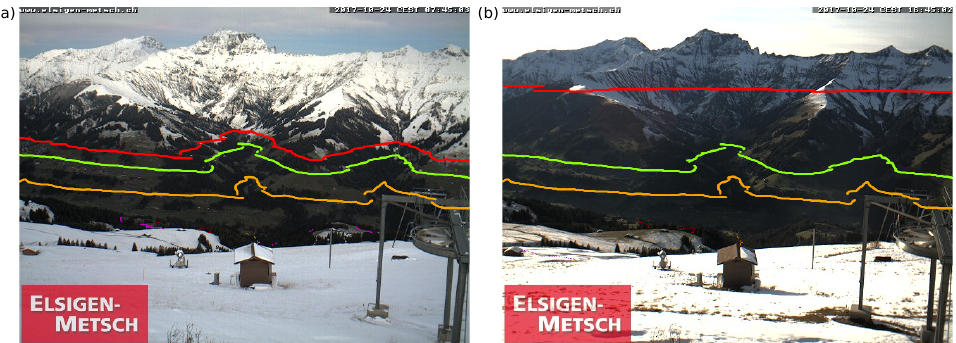
Figure 12. Regional snow line elevation (RSLE) differences on 24 October 2017 at ( a ) 7:45 and ( b ) 16:45 local time (UTC+2) between hourly webcam RSLE (red line) and MOYD RSLE using an NDSI of 0.1 (orange line) and 0.4 (green line). Webcam image: Frutigen Metschalp (© elsigen-metsch.ch (accessed on 24 March